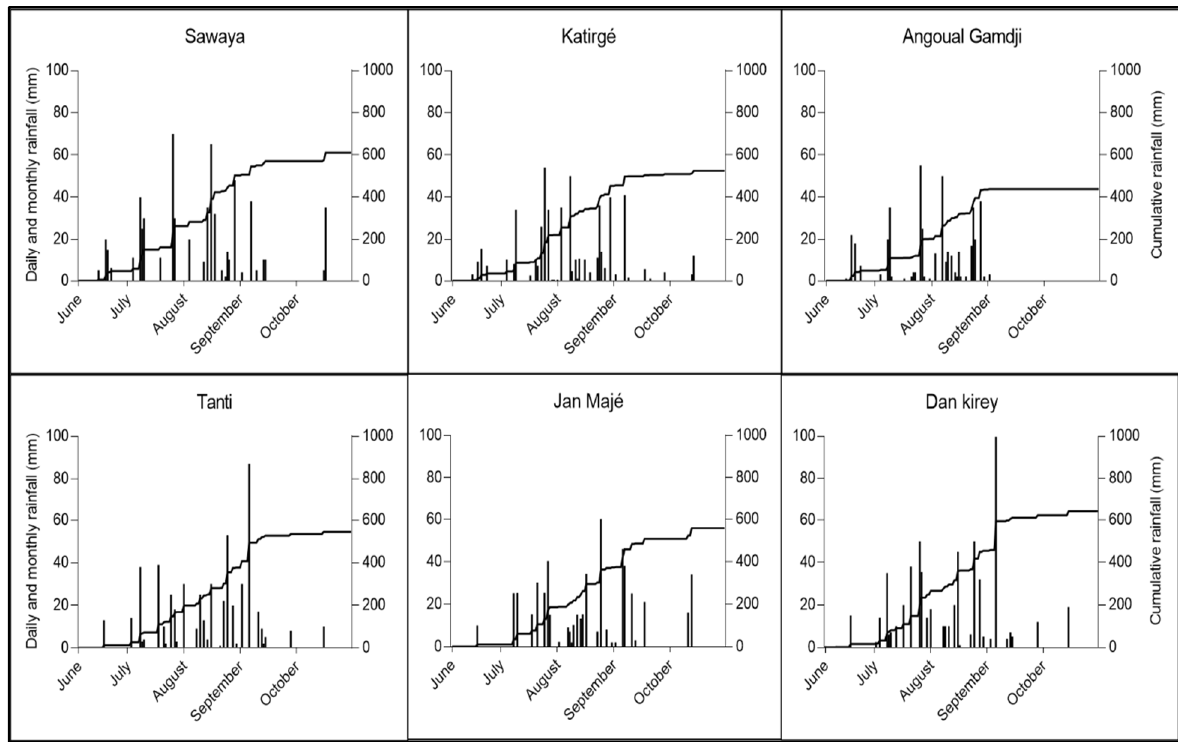
Figure 4. Daily and cumulative rainfall during the growing season at the study sites. Similar weather conditions were observed across study sites for temperature and relative humidity. During the trials, regardless of the study site, the maximum temperature varied from 25.63 °C (October) to 42.11 °C (June) while the minimum temperature varied from 28.13 °C (June) to 15.01 °C (October). The relative humidity varied from 93.44% to 32.88% (Figure 5).